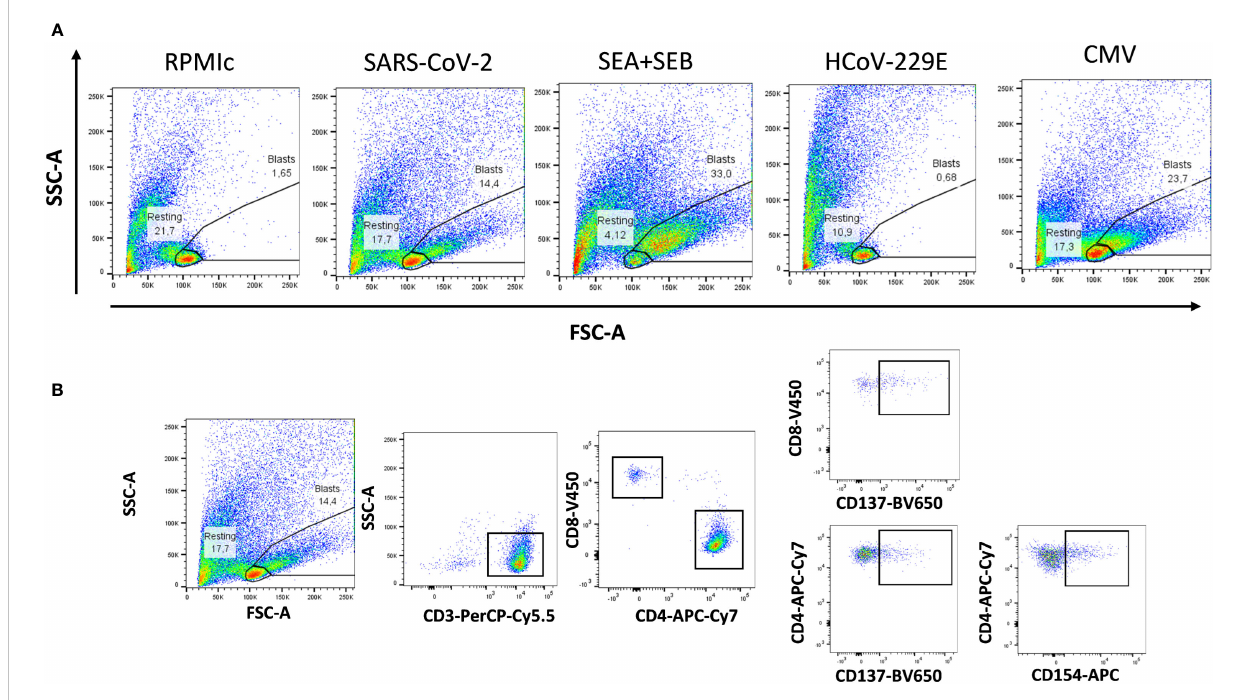
FIGURE 2 Flow cytometry gating strategies for analyzing proliferative reactivity of T cells. (A) Representative T-cell proliferation after whole blood stimulation with SARS-CoV-2, Staphyloccocus aureus toxins, common cold coronavirus HCoV-229E and CMV as well as unstimulated whole blood (medium) are shown. (B) Representative gating strategy for analyzing CD3+, CD4+ and CD8+ T-cell proliferation. Expression of activation markers (CD137 and CD154) was analyzed separately in CD4+ and CD8+T